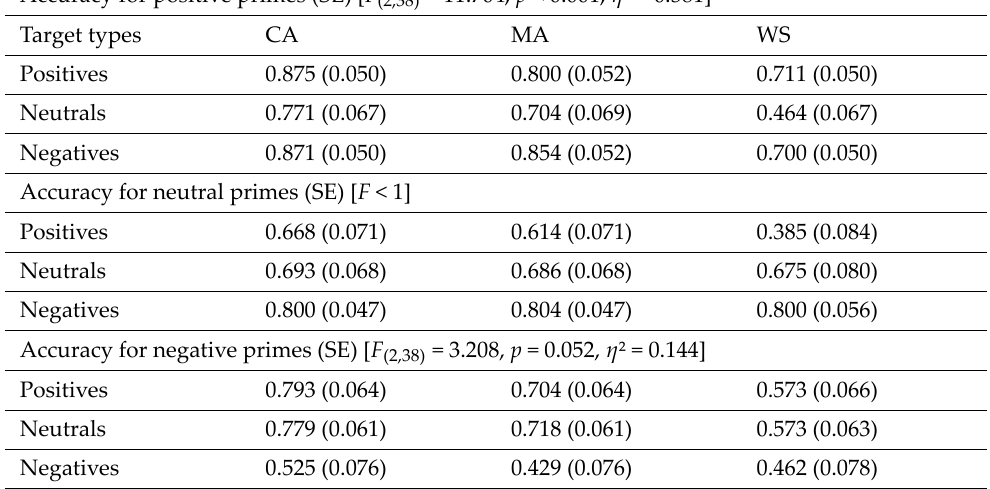
Table 2. Matrix of accuracy for the three groups in responses to three types of targets given the three types of